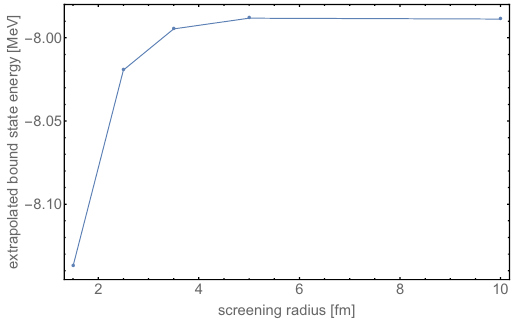
Figure 1. Convergence of the 3 He bound state energy with the screening radius R . The bound state energy converges to E ≈ − 7 . 989 [MeV] above R = 10 [fm]. For the screened Coulomb potential used in the calculation [10], the potential goes to 0 at 3 R = 30 [fm]. We used first generation NNLO 2N [6] and 3N [7] potentials and simplified the preliminary calculations by using only the 2N neutron-proton